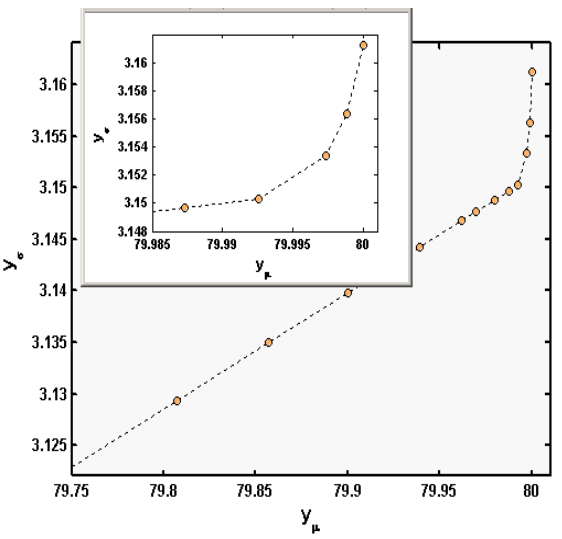
Figure 11. Pareto frontier obtained by following optimization of the two responses (The inserted box shows the Pareto frontier in the second zone) It seems unlikely the decision-maker can accept these solutions. In the second zone, the mean response reaches its topmost values, while the standard deviation also increases but acceptably.